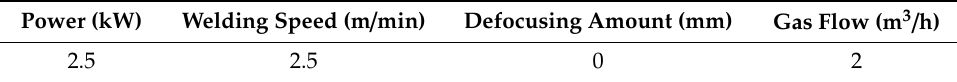
Table 3. Laser welding process